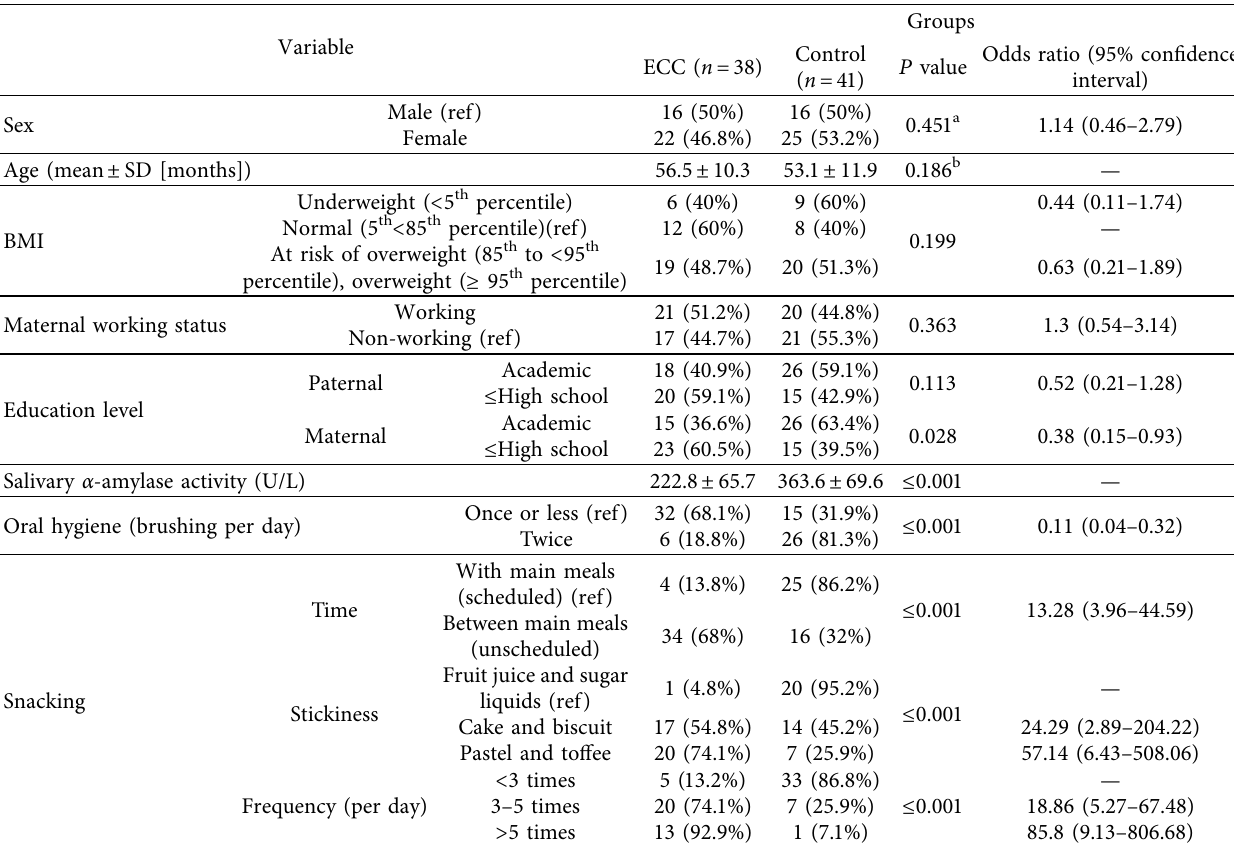
Table 1: Distribution of general characteristics of the case and control